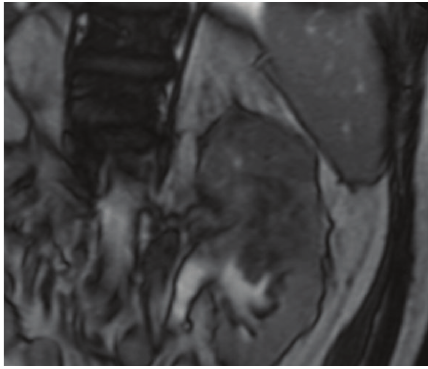
Figure 9: Coronal T2-weighted MRI of kidneys shows a large heterogeneous low T2 signal mass centered in the upper pole of the left